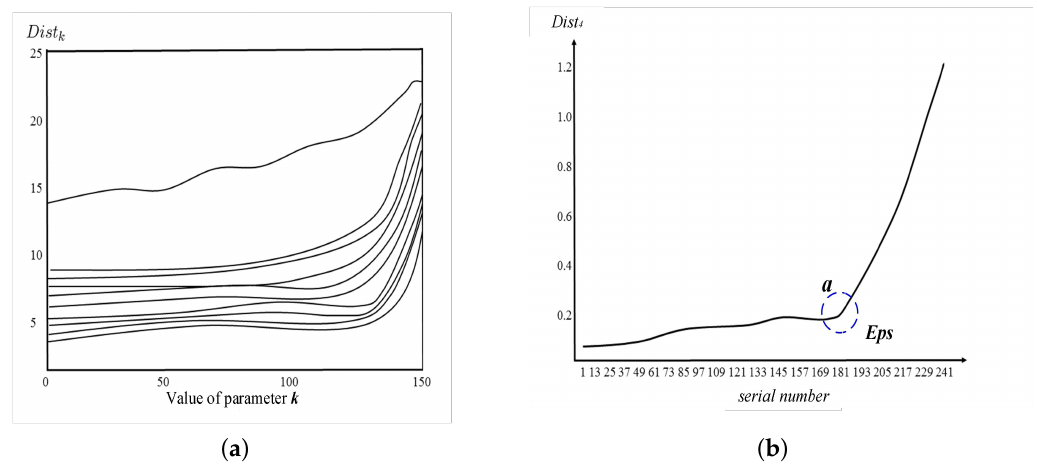
Figure 1. Dist k distribution of a single density hierarchical dataset ( a ) Threshold parameter MinPts value is not fixed, Dist k distribution effect; ( b ) Threshold parameter MinPts = 4, distribution of sample points Dist k